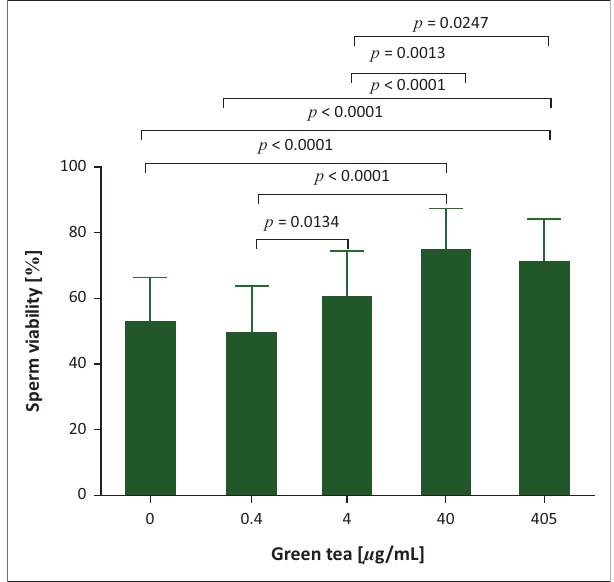
FIGURE 1: Effect of green tea aqueous extract on human sperm viability. Data are represented as mean ± standard deviation from normozoospermic semen samples ( n = 40).